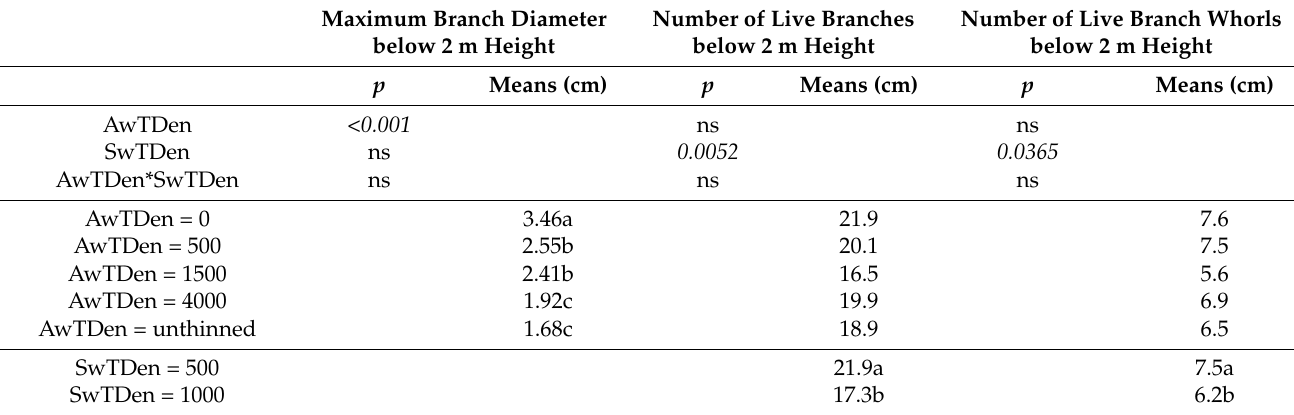
Table 4. Effects of thinning treatments on maximum branch diameter, number of live branches, and number of live branch whorls in the lower 2 m of dominant spruce. Analysis for treatment effects was based on a factorial design with three levels for aspen density and two levels for spruce density. For both aspen treatment density (AwTDen) and spruce treatment density (SwTDen), means followed by different letters were found to differ significantly ( α = 0.05) based on Tukey’s HSD